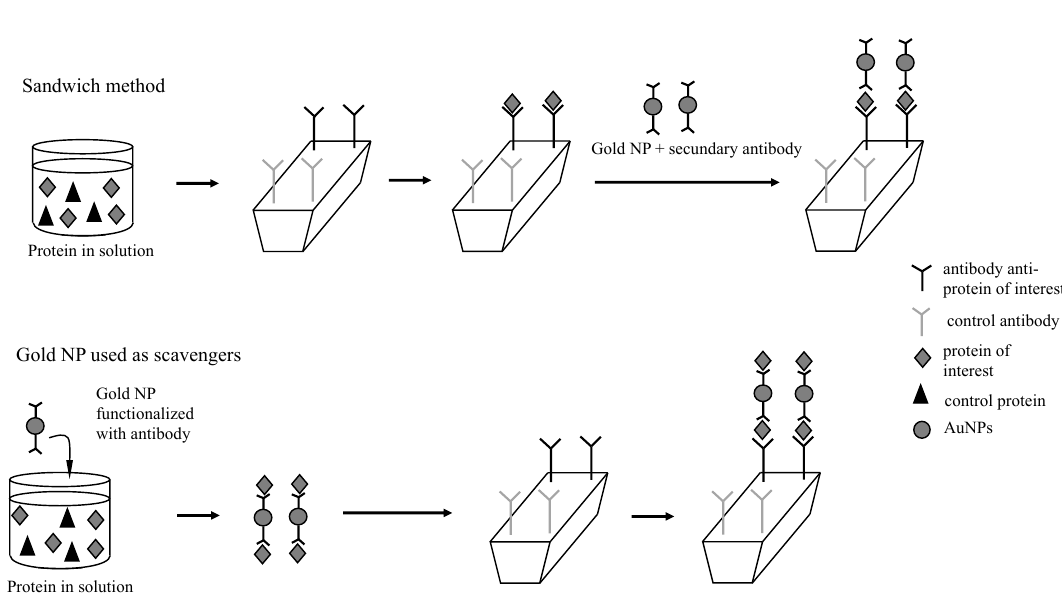
Figure 1. Comparative representation of the application of gold NPs in the sandwich method, where the proteins in solution are directly injected on the biosensor, and the application of gold NPs as protein scavengers, where the NPs are firstly mixed with the proteins in solution and then injected on the biosensor.